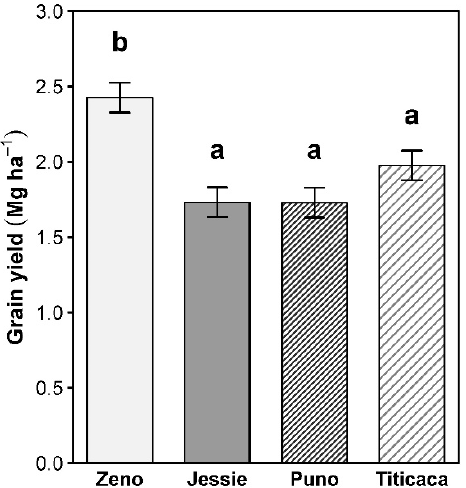
Figure 2. Two-year mean values of grain yield (Mg ha − 1 ) for the four quinoa cultivars (Zeno, Jessie, Puno, Titicaca). Bars headed by the same letter are not significantly different at p < 0.05. Error bars indicate the standard error of the mean.